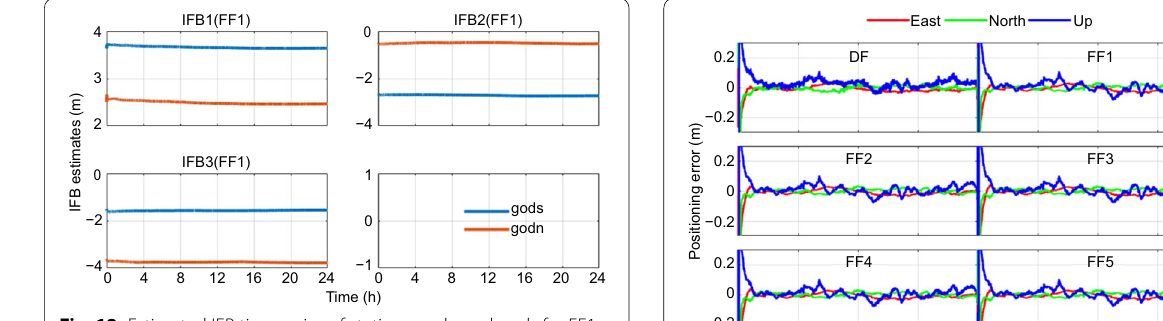
Fig. 12 Estimated IFB time series of stations godn and gods for FF1 models (DOY 283, 2021)